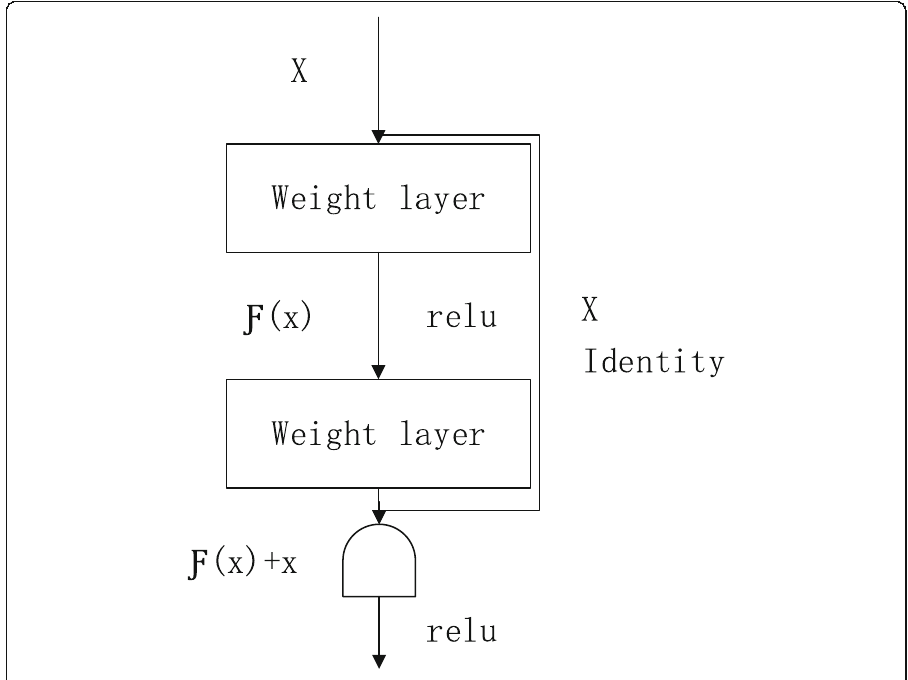
Fig. 4 Cross-layer connection structure